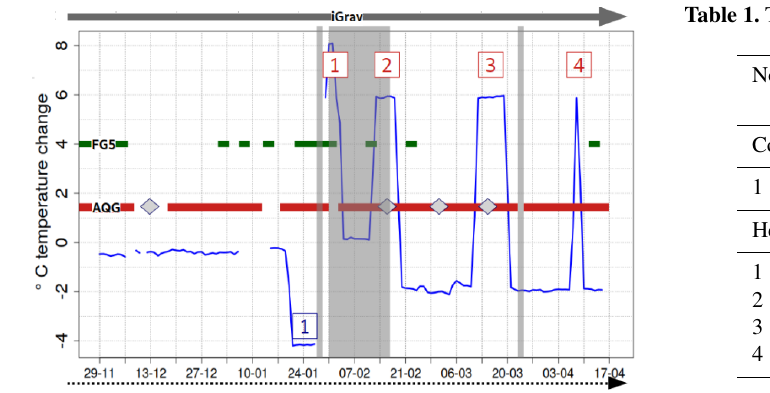
Figure 2. Timeline and data availability for the campaigns at Larzac observatory December 2019–April 2020. The AQG-B01 data se- ries are marked in red; the FG5-228 measurements are marked in dark green. The iGrav-002 measured continuously (marked in dark grey). AQG-B01 data at dates marked in grey in later January, early February, and late March were not considered in the analysis, due to inconsistencies during the experiments, as explained in Sect. 4.4.2. The thin blue line represents the residuals from the mean observa- tory temperature to illustrate the temperature tests. One test has been carried out at reduced temperatures and four at increased tempera- tures. Grey diamonds during the AQG-B01 series mark the dates of tilt tests carried out on the AQG-B01.